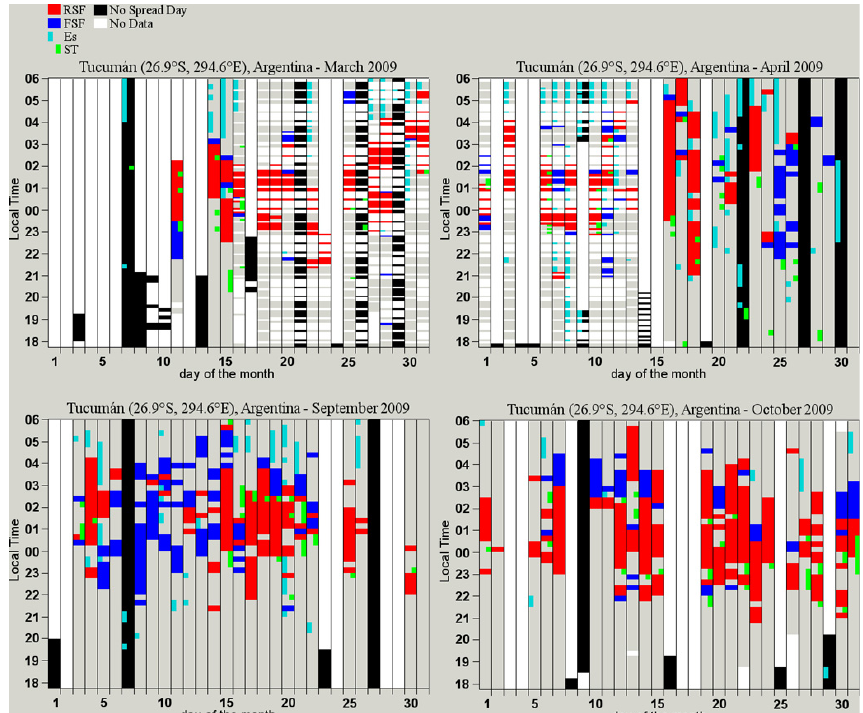
Fig. 9. Same as Fig. 5 for Tucum´an, Argentina.